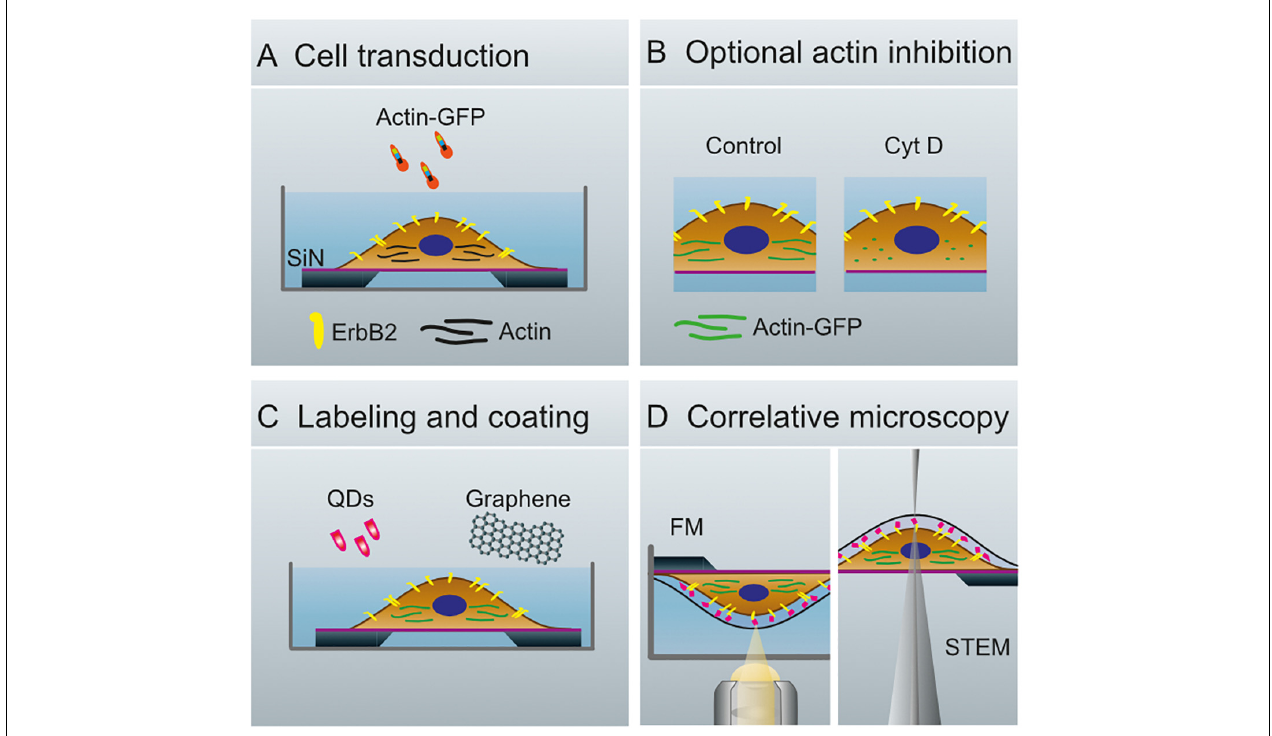
FIGURE 1 | Schematics of whole cell preparation for the analysis of membrane proteins. (A) Transduction of SKBR3 cells, seeded on silicon microchips with a silicon nitride membrane, with actin-green fluorescent protein (GFP)-constructs and cultivation of cells for 40 h. (B) Cells remain untreated (Control, left) or are treated with Cytochalasin (Cyt) D (right). (C) Membranous ErbB2 is labeled with streptavidin coated quantum dots (QDs) via Affibody-biotin conjugates. The cells are covered with graphene to protect against evaporation of the liquid in the vacuum of the electron microscope. (D) Configuration for fluorescence microscopy (FM, left), and for scanning transmission electron microscopy (STEM,